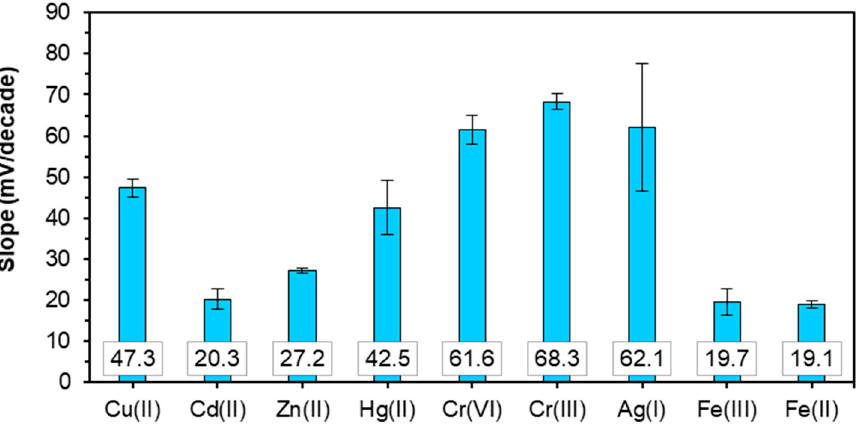
Figure 8. Slopes of the electrode function of the LS-based PU sensor doped with 1% w / w MWCNTs at pH 7 (mean values of at least three calibrations with their respective standard deviations).